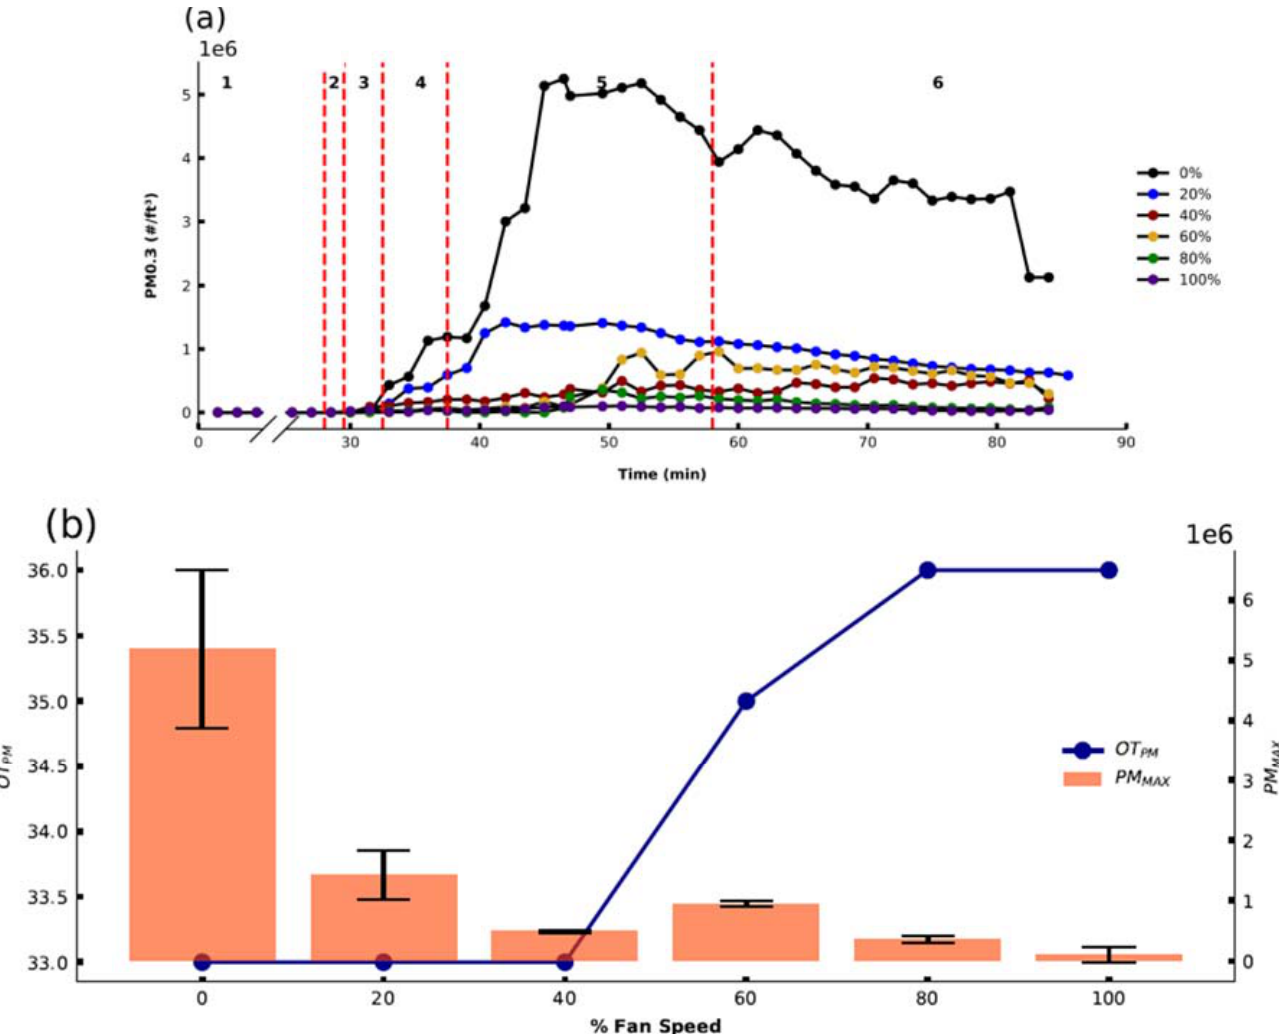
Figure 4. ( a ) PM 0.3 profiles for different fan speeds over time before, during, and after the printing of the test cube using PLAB8b (bedplate temp: 50 ◦ C, extruder temp: 205 ◦ C, 20% infill), ( b ) OT PM (left axis, scatterplot), and PM MAX emissions (right axis, box plot) extracted from data in ( a